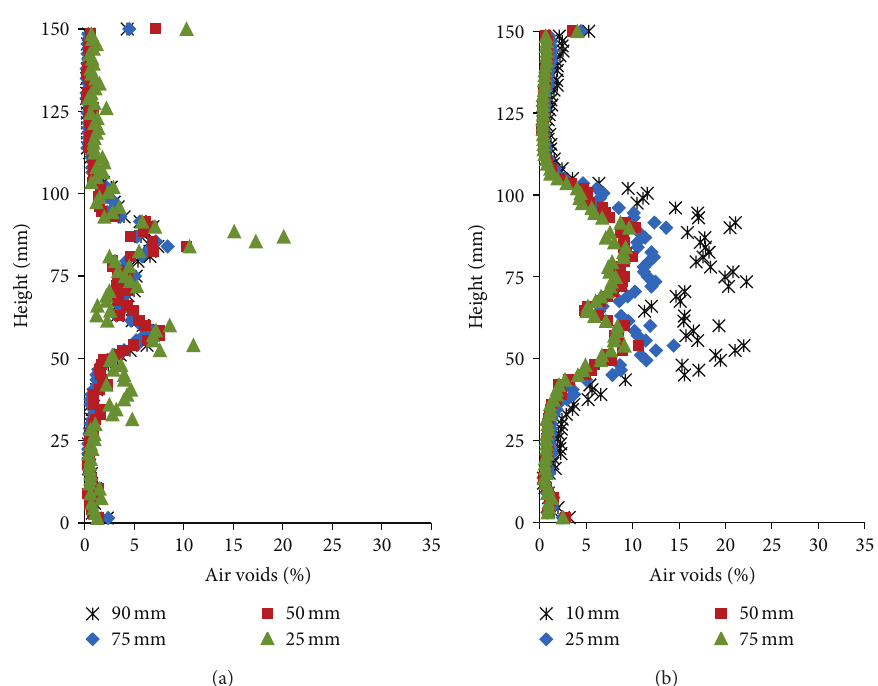
Figure 7: Air voids distribution within the virtual cut of (a) core and (b) ring for specimen 1.